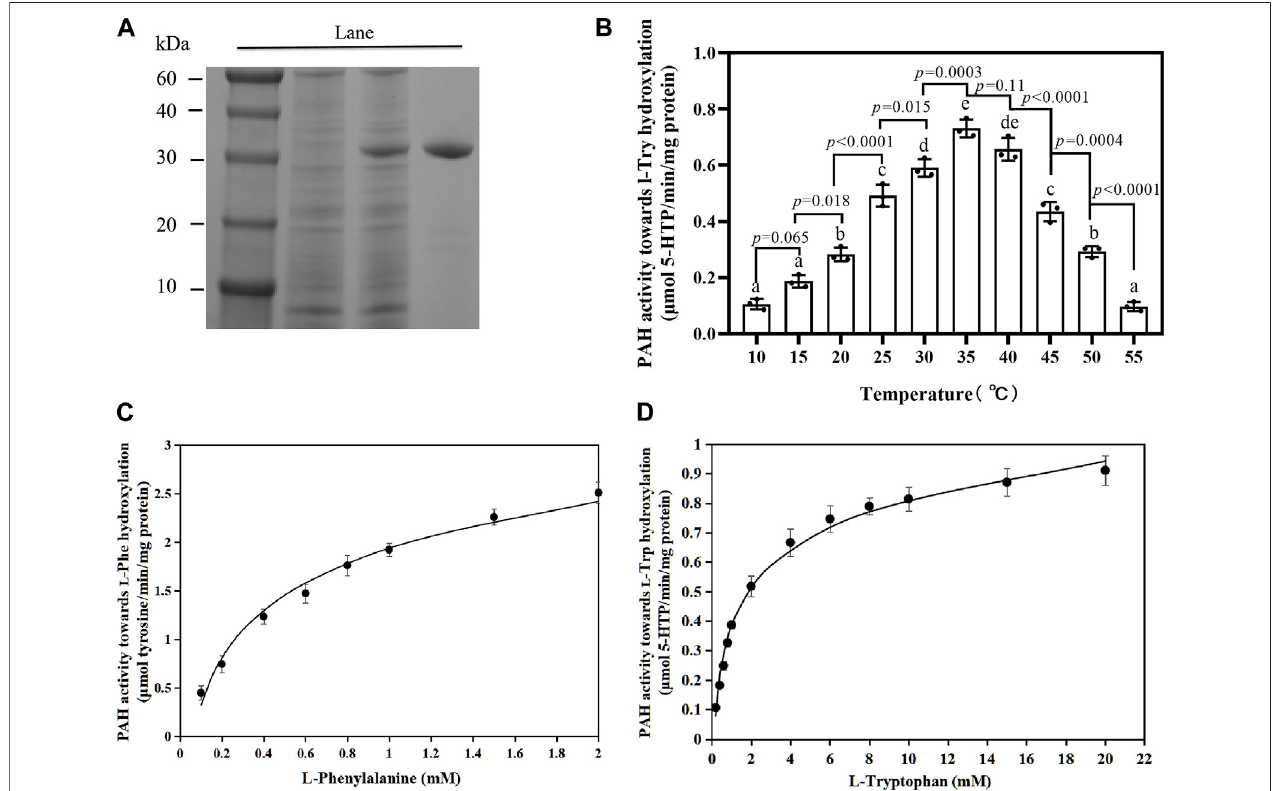
FIGURE 3 | PfPAH protein characterization. (A) PfPAH puri fi cation in E. coli . SDS-PAGE image shows molecular mass markers in Lane 1, total protein of bacterial cells without IPTG in Lane 2, total protein after IPTG treatment in Lane 3, and puri fi ed PfPAH in Lane 4. (B) Effect of temperature on PfPAH L -Trp hydroxylase activity measured with 20 mM L -Trp, 0.5 mM BH 4 , and 100 μ M FeSO 4 . Each data point represents the mean ± standard deviation ( n (cid:2) 3). Different letters indicate signi fi cant difference by Tukey ’ s multiple comparison test ( p < 0.05). (C) Effect of L -Phe concentration on PfPAH hydroxylase activity for L -Phe. (D) Effect of L -Trp concentration on PfPAH hydroxylase activity for L -Trp. The curves in Figures 3C,D were fi t to the non-linear Michaelis – Menten equation.